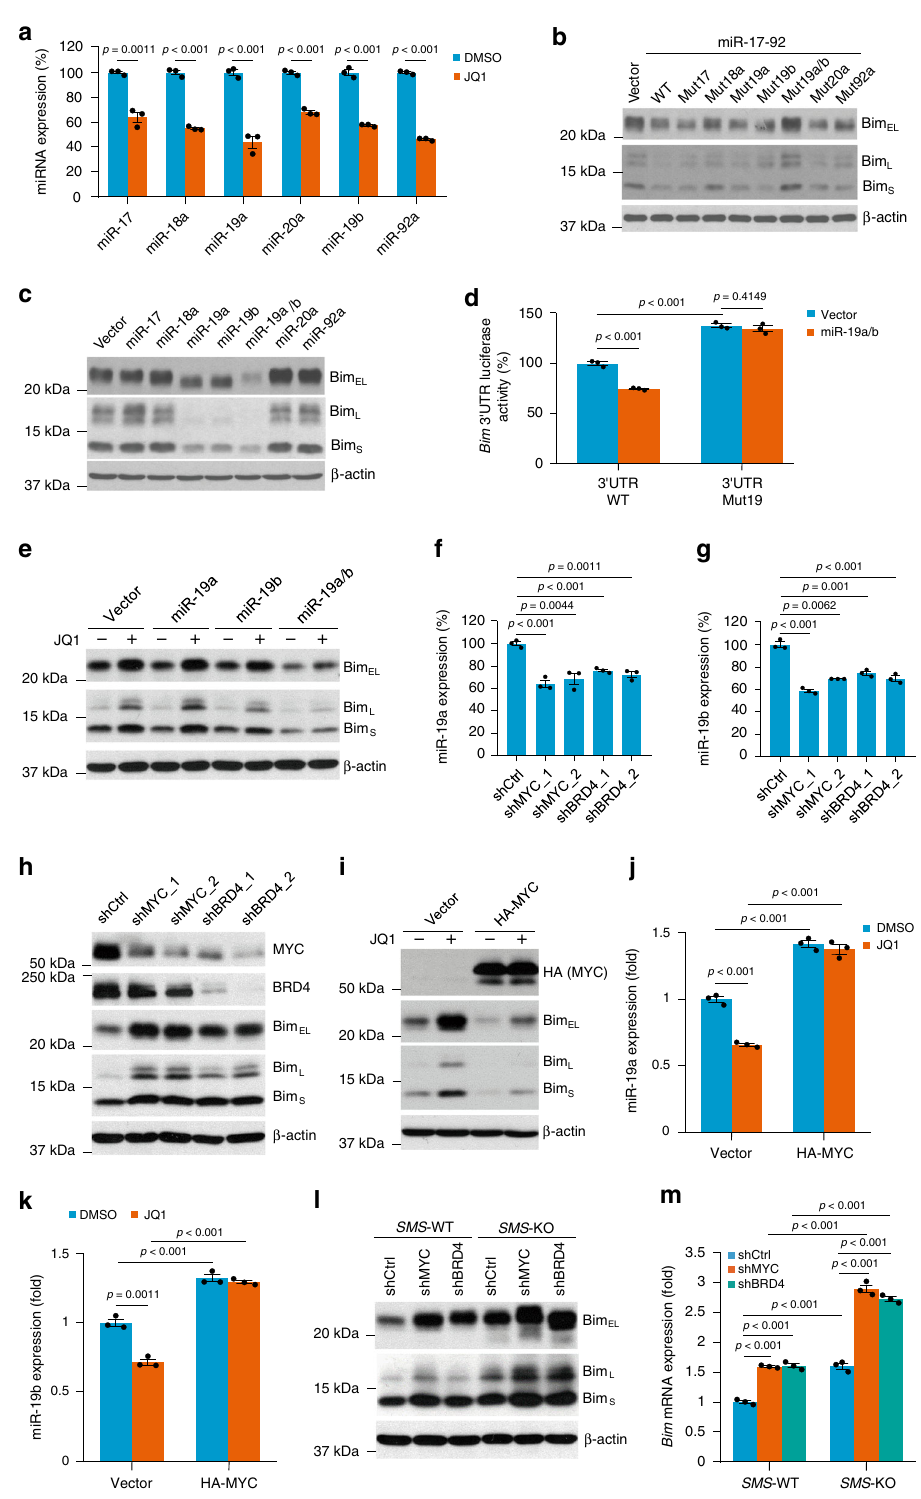
Conversely, reduction of spermidine levels by treatment with the ODC inhibitor DFMO, attenuates apoptosis induced by different cell death stimuli 19,52 . In addition, several studies have demon- strated that spermidine production resulting from SRM expres- sion or direct treatment with spermidine signi fi cantly suppress cell growth in vitro and in vivo models of CRC 53 and hepato- cellular carcinoma 54 , which is likely mediated by induction of autophagy through transcriptional and epigenetic regulation 48,55